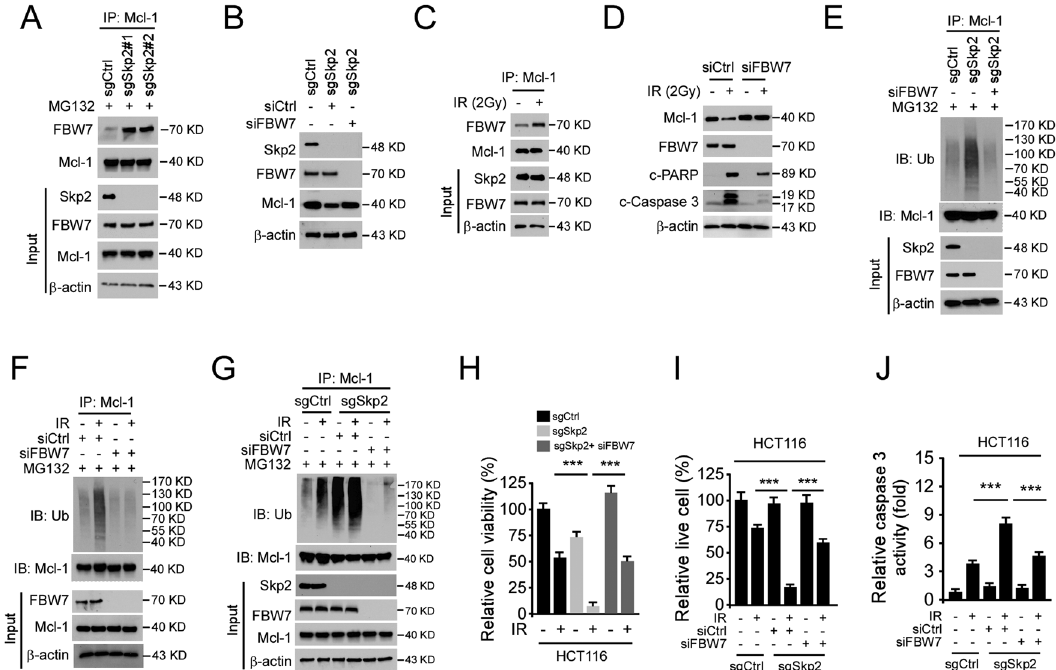
Fig. 5 FBW7 is required for IR-induced Mcl-1 ubiquitination. A Skp2 knockout HCT116 cells were treated with MG132 for 6 h, WCE was subjected to co-immunoprecipitation (Co-IP) analysis. B siFBW7 was transfected into Skp2 depleted HCT116 cells and subjected to IB analysis. C HCT116 cells were treated with IR (2 Gy), WCE was collected 1 h later and subjected to Co-IP analysis. D siFBW7 was transfected into HCT116 cells for 24 h, followed by IR (2 Gy) treatment. Cells were cultured for 72 h, WCE was subjected to IB analysis. E siFBW7 was transfected into Skp2 depleted HCT116 cells for 48 h, followed by MG132 treatment for 6 h, WCE was subjected to IP-mediated Mcl-1 ubiquitination analysis. F HCT116 cells were transfected with siCtrl or siFBW7 and cultured for 48 h. After being incubated with MG132 for 6 h, the cells were treated with IR. WCE was collected 1 h later and subjected to IP-mediated Mcl-1 ubiquitination analysis. G – J Skp2 depleted HCT116 cells were transfected with siCtrl or siFBW7 and cultured for 48 h. After being incubated with MG132 for 6 h, the cells were treated with IR. WCE was collected 1 h later and subjected to IP-mediated Mcl-1 ubiquitination analysis ( G ). Cell viability and live cell population was determined by MTS assay ( H ) and trypan blue exclusion assay ( I ), respectively. Caspase 3 activity was examined by Caspase 3 Assay Kit ( J ). *** p <